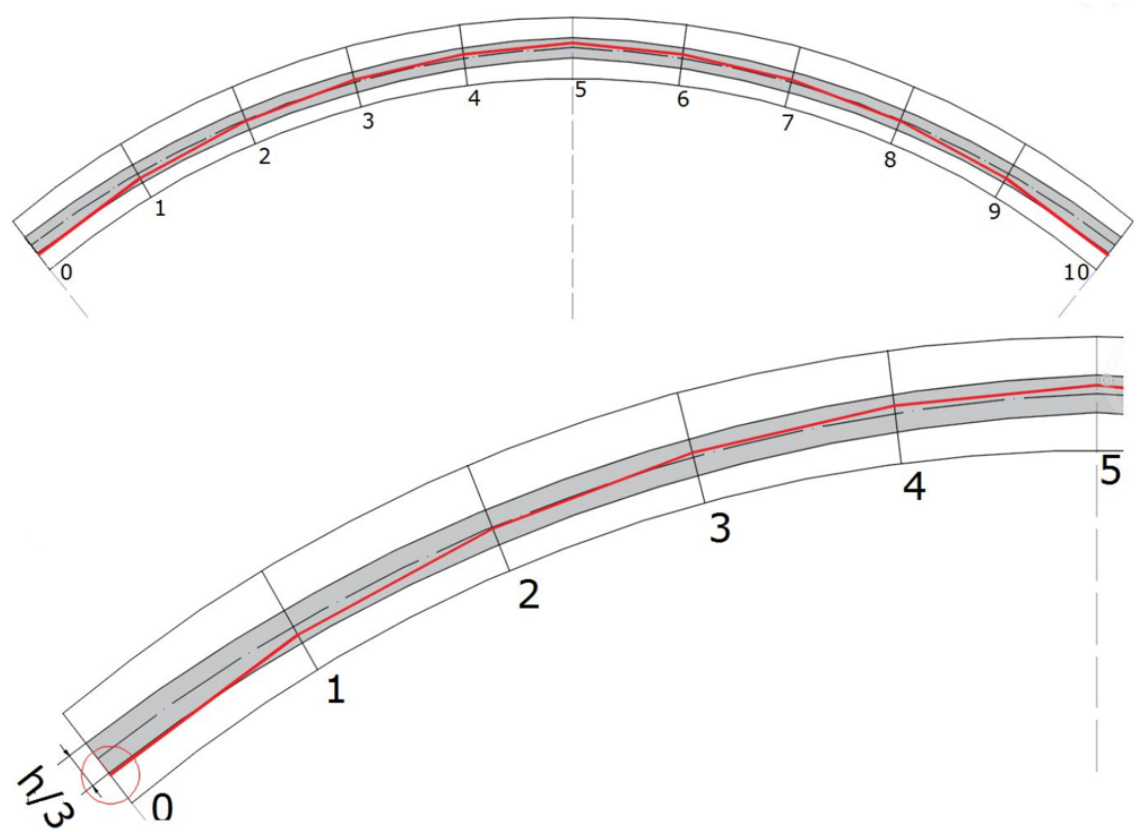
Figure 8: Thrust line of the Porta Napoli arch.